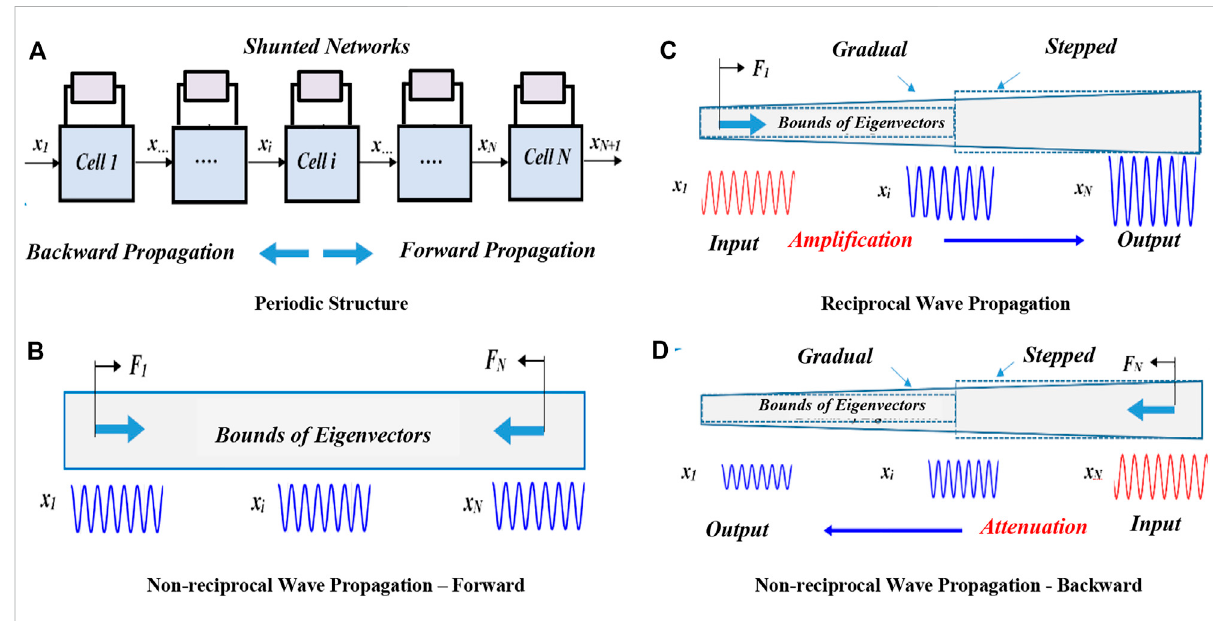
FIGURE 1 A schematic drawing of a 1D periodic dynamical